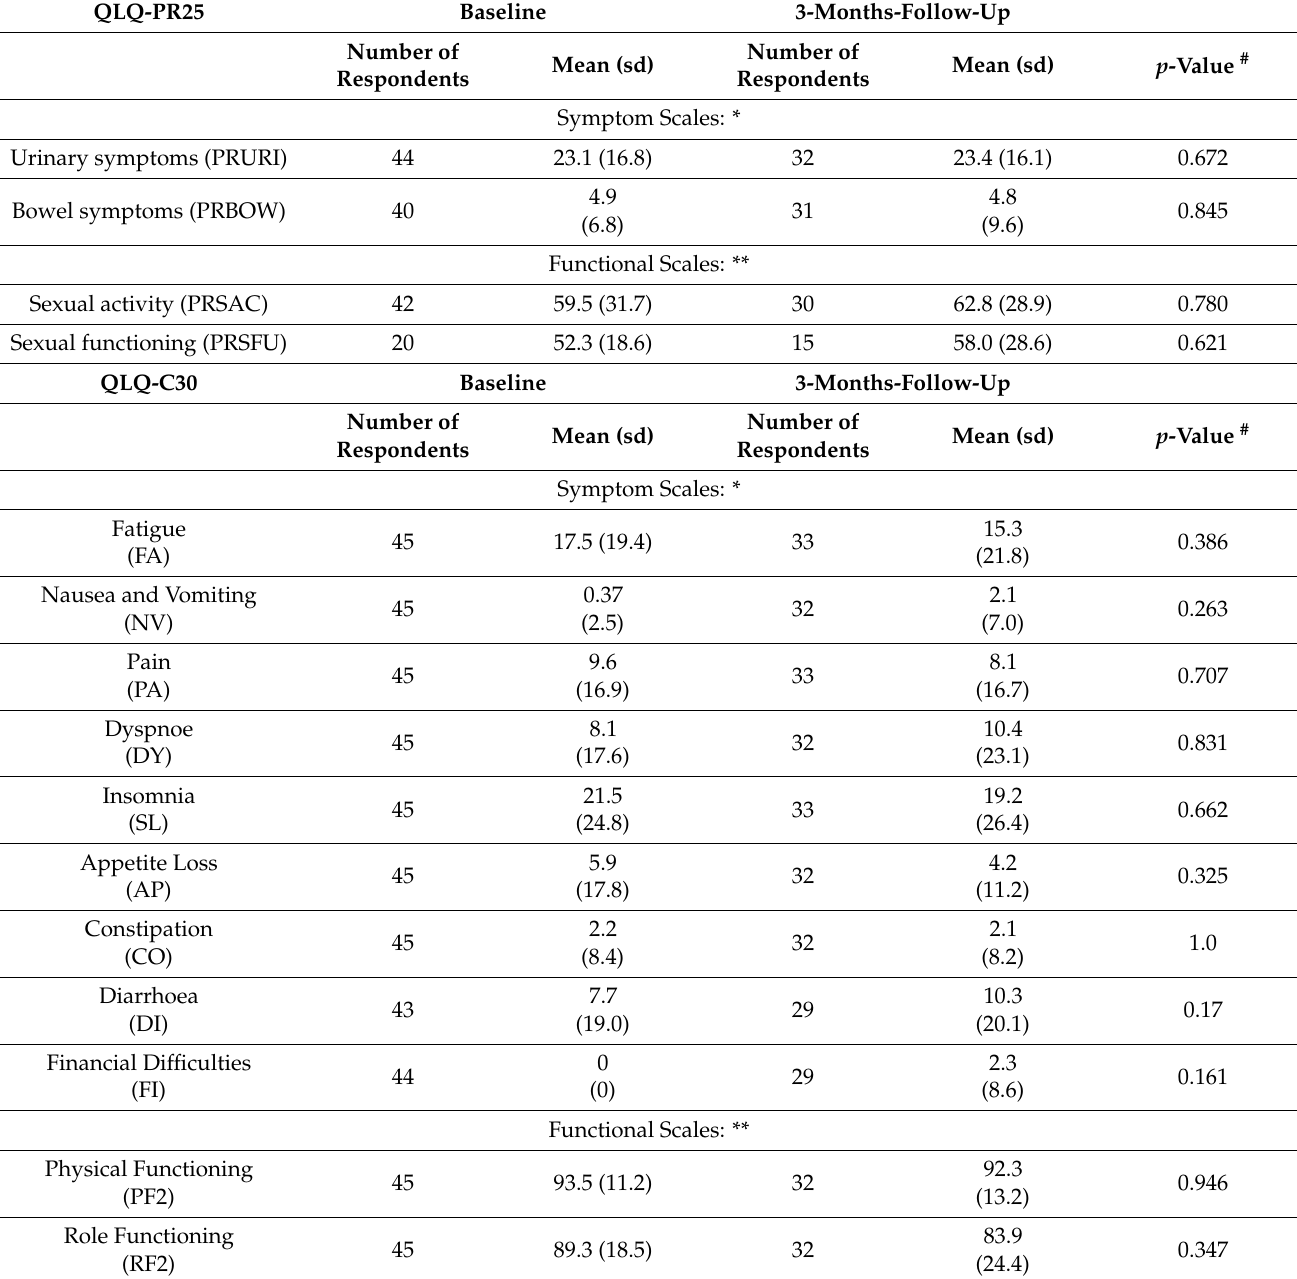
Table 5. Baseline and early patient reported quality of life scores (QLQ-C30 +